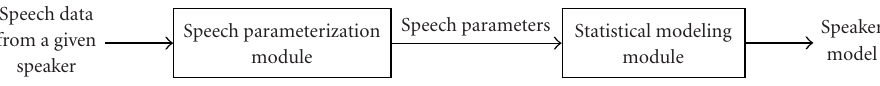
Figure 1: Modular representation of the training phase of a speaker verification system.